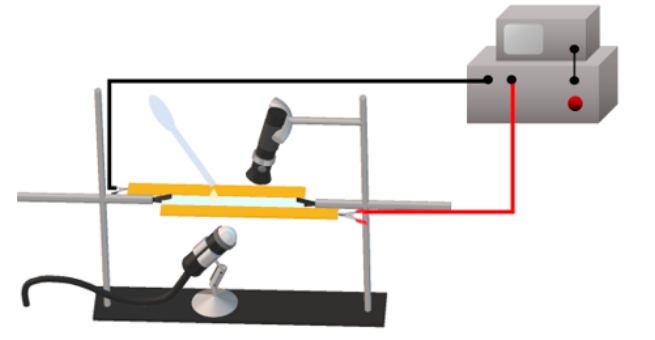
Figure 2. In-situ microscopy set up.